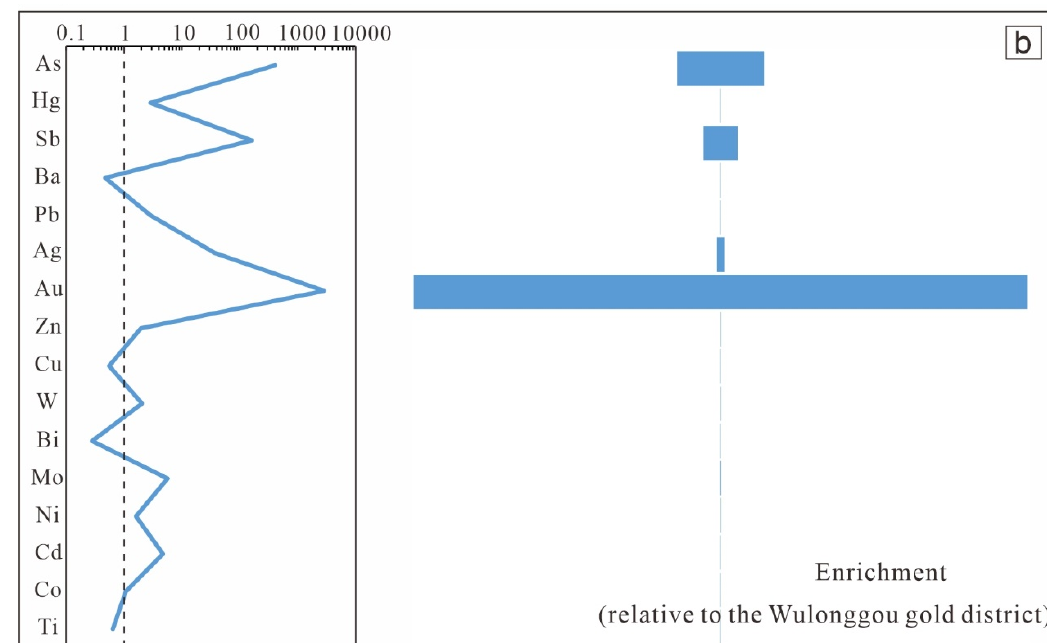
Figure 13. Elemental enrichment in the Yanjingou ore body relative to the wall-rocks and Wulonggou Au district. a: elemental enrichment relative to the wall-rocks; b: elemental enrichment relative to the Wulonggou Au district.